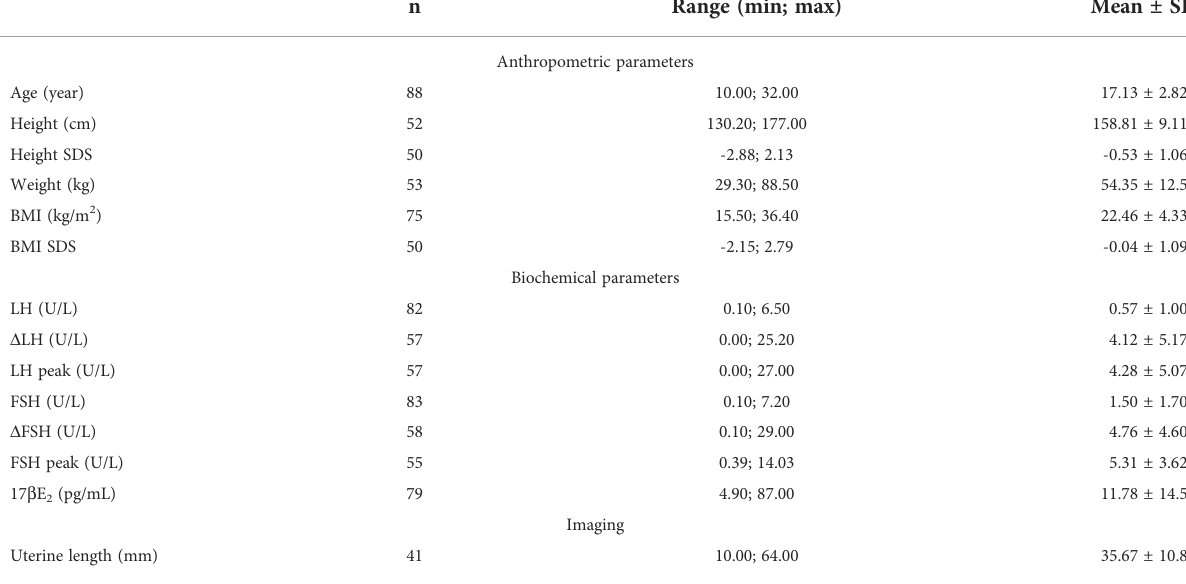
TABLE 1 Anthropometric and hormonal parameters of female